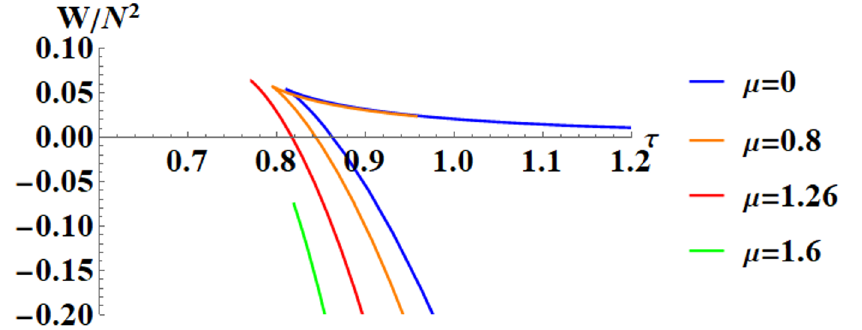
Figure 14 . The BPS free energy W vs. the BPS temperature τ for select values of the potential µ ≥ 0 that parametrizes the asymmetry between angular momenta. µ = 0 , 0 . 8 , 1 . 26 , 1 . 6 from right to left. For small µ , the phase diagram exhibits the familiar lower (large) and upper (small) black hole branches that meet in a cusp. For the small black hole branch, there is a maximal BPS temperature that decreases as function of µ and reaches the cusp at some µ = µ . The maximal crit value of W also increases with µ ≤ µ but then decreases for µ > µ crit crit